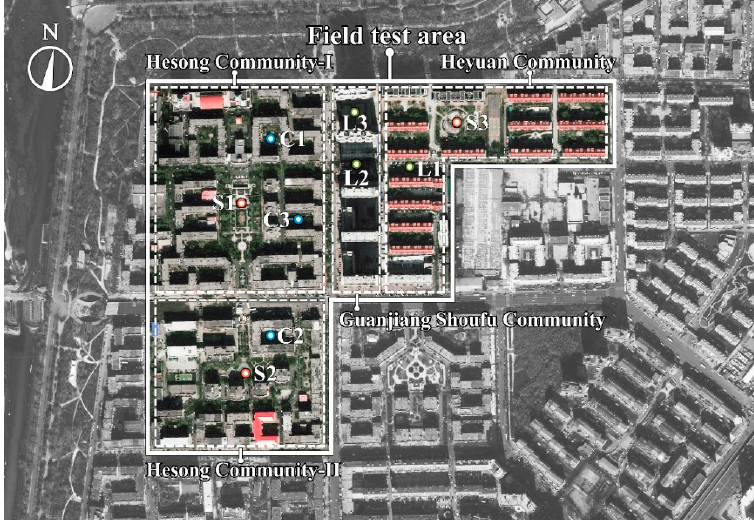
Figure 1. Field measurement site, locations of the selected residential areas and measurement points.